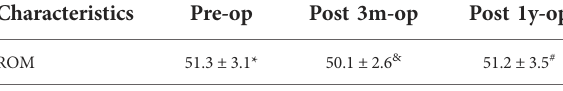
TABLE 2 Comparation of the ROM between pre and